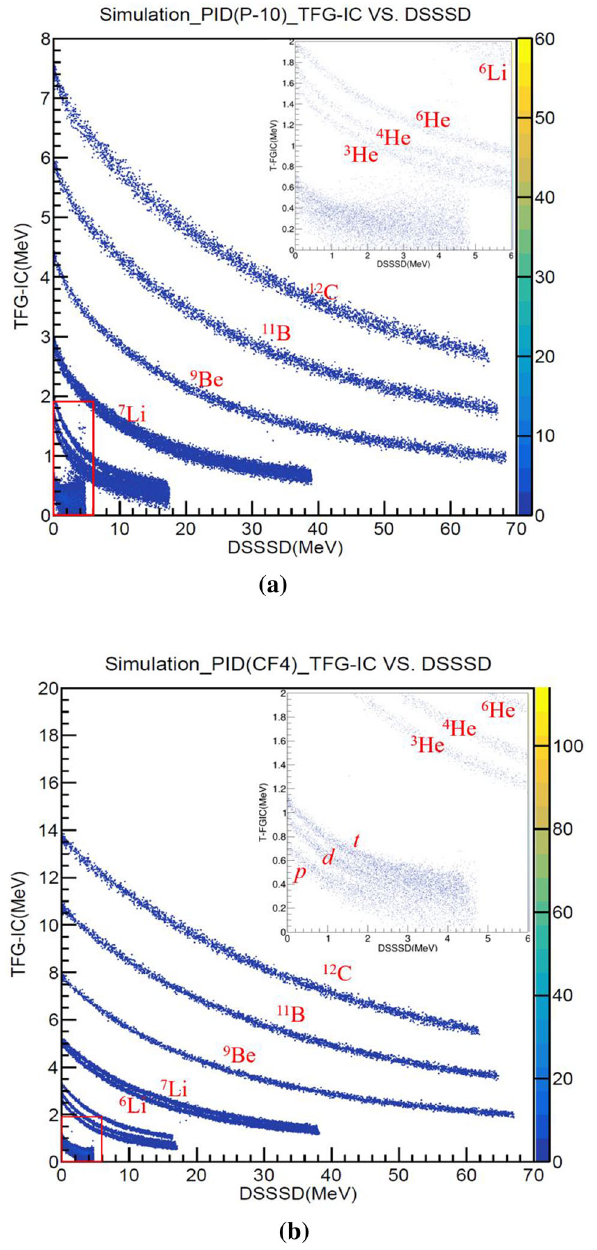
Fig. 13 Δ E - E correlation in the TFG-IC + DSSSD telescope for sim- ulated data: Working gas P10 ( a ) and Working gas CF 4 ( b )